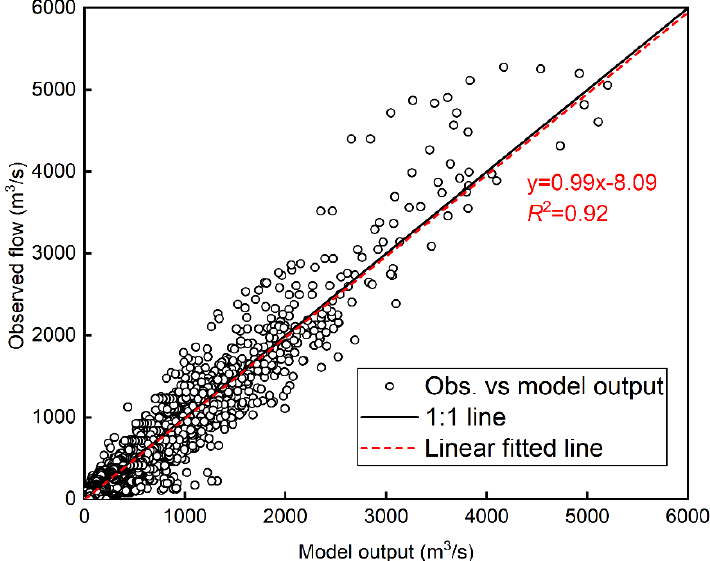
Figure 3. Scatter plot of hourly flow observations and the discharge simulated by the calibrated XAJ model for all 22 flood events. The fitted linear trend (red dashed line) and the 1:1 line (black solid line) are also shown.